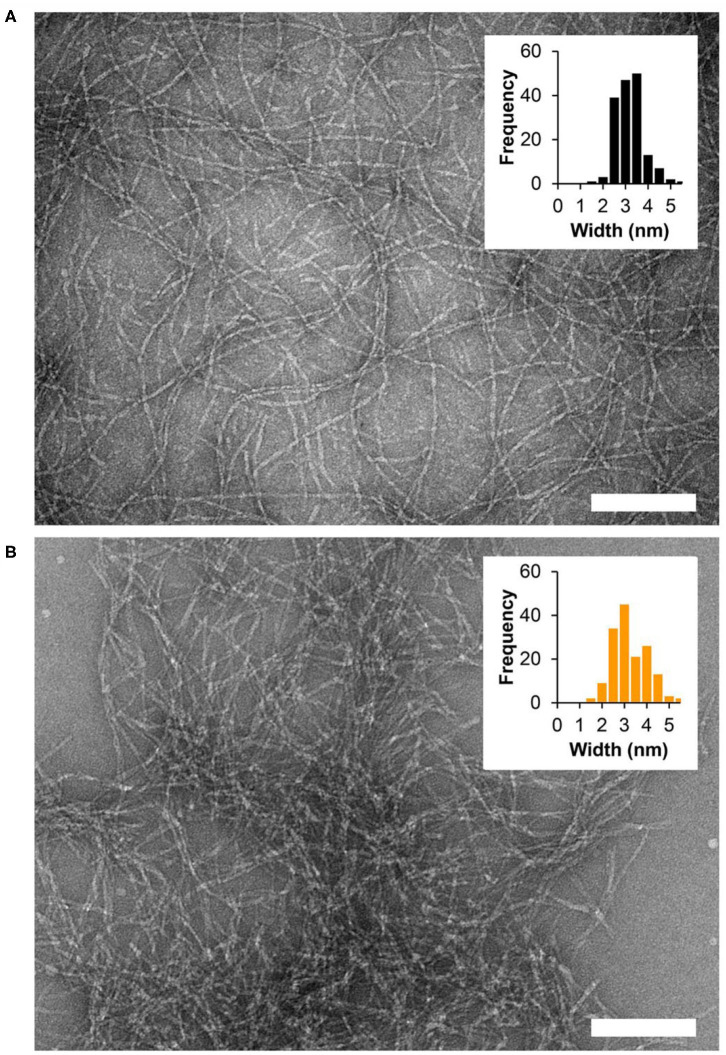
TEM micrographs showing fibrils isolated from 1 wt% fibrillar gel networks (A) in the absence of oxidant or (B) following overnight oxidation with Frémy's salt. Scale bar = 100 nm. Widths of individual fibrils were determined using ImageJ software, n = 164 and n = 156 for the non-oxidized and oxidized gel, respectively.